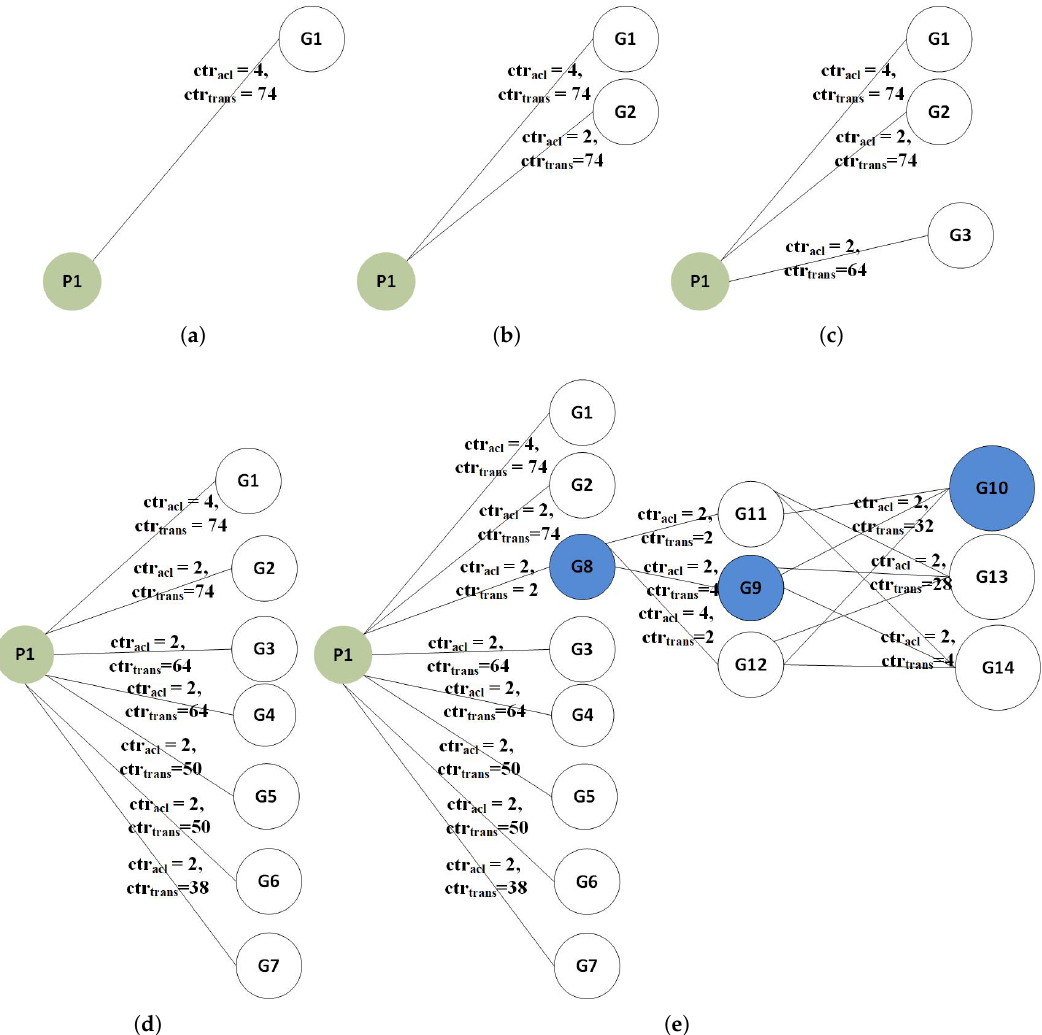
Figure 13. Step by step formation of K-partite graph. ( a ) A group G1 is formed that is attached with node P1 forming a K-partite graph; ( b ) A group G2 is formed that is attached with node P1 forming a K-partite graph; ( c ) A group G3 is formed that is attached with node P1 forming a K-partite graph; ( d ) Multiple groups G4–G7 are added to graph forming a K-partite graph; ( e ) Groups G8, G9 and G10 are added in the K-partite graph as a series of edges for collective ACL